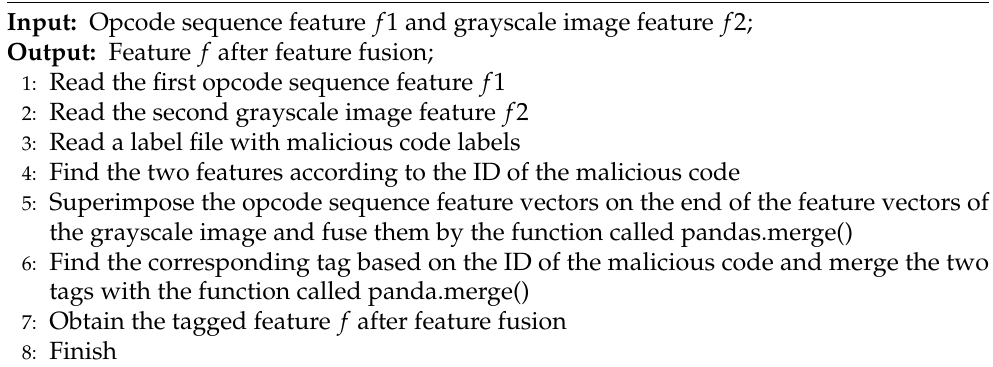
Algorithm 2 Feature fusion algorithm